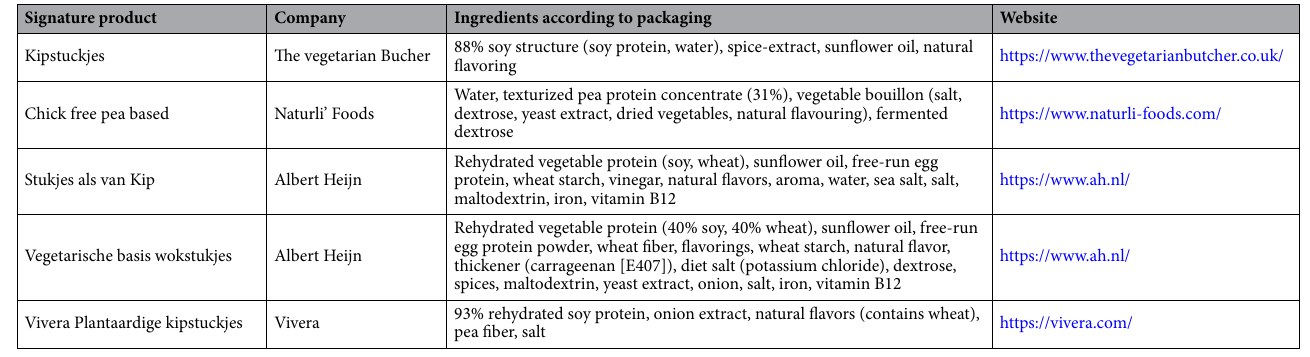
Table 3. Description of meat analogues and ingredients according to the